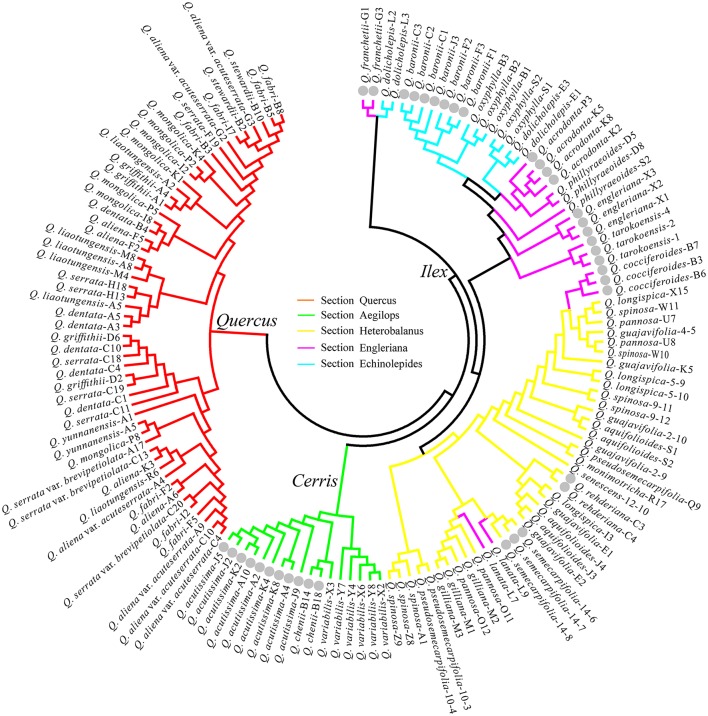
NJ tree of the highest species identification rate with the combination of psbA-trnH + matK-trnK + ycf3-trnS + ycf1 + ITS + SAP shows the phylogenetic implications for the Chinese oak species of Quercus subgenus Quercus. Gray dots highlight the individuals of identified oak species.